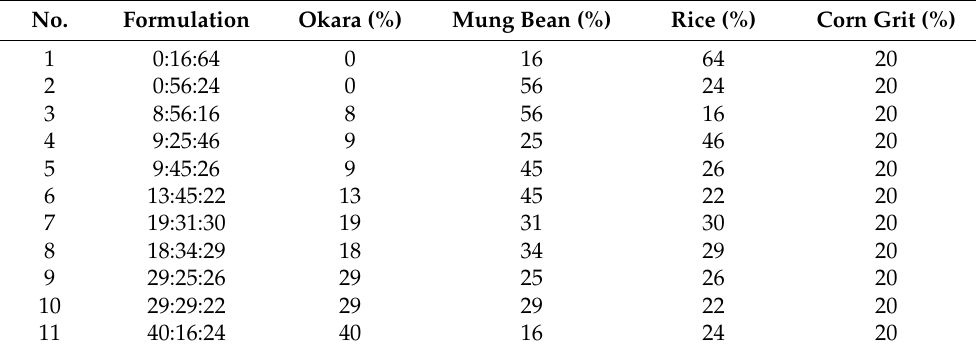
Table 1. The proportion of three mixtures of grain flours generated from extreme vertices mixture